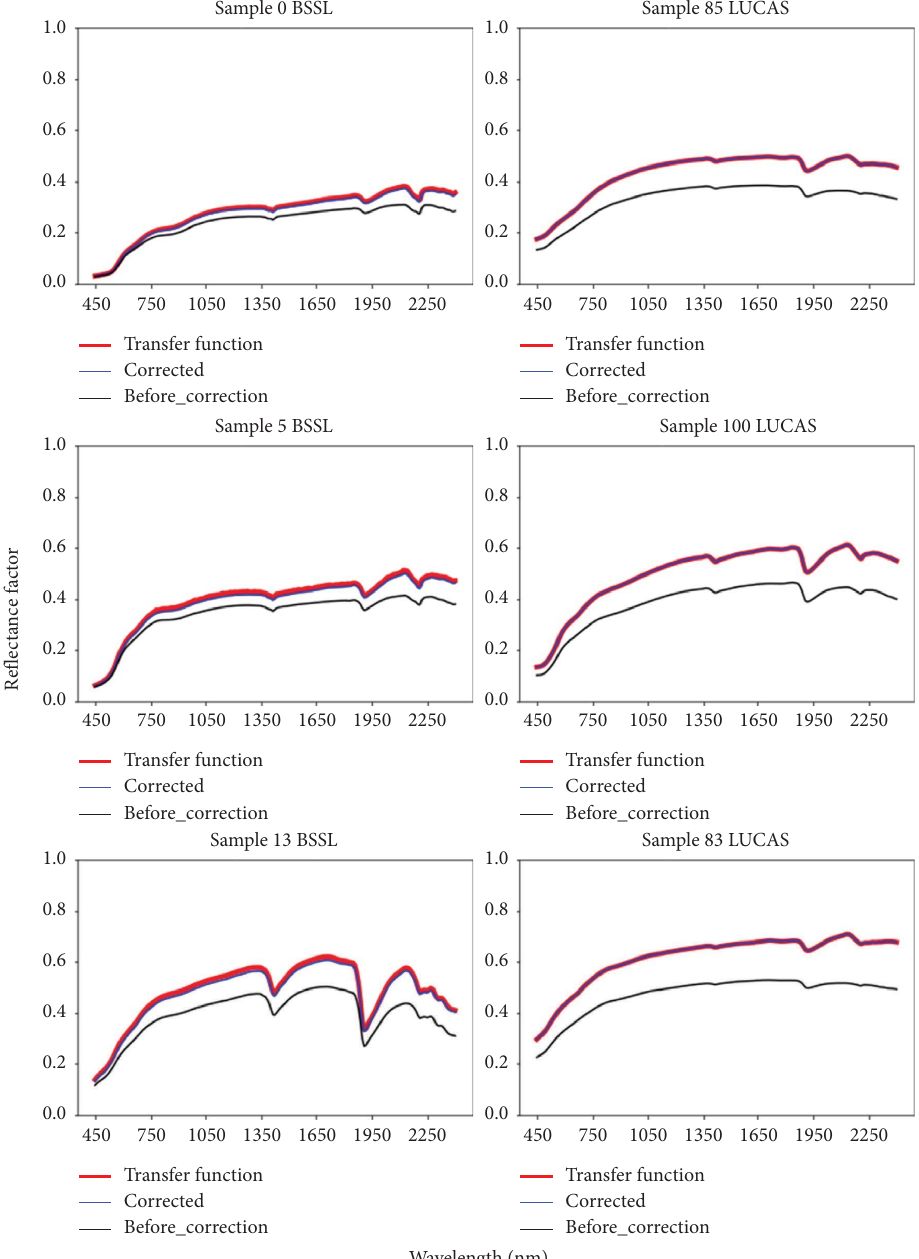
Figure 3: Examples of the TFs1 rectifcation process in the rectifcation group: red—TF (trained with new measurements) spectra, blue—corrected (ISS) spectra, and black—measured spectra before the ISS